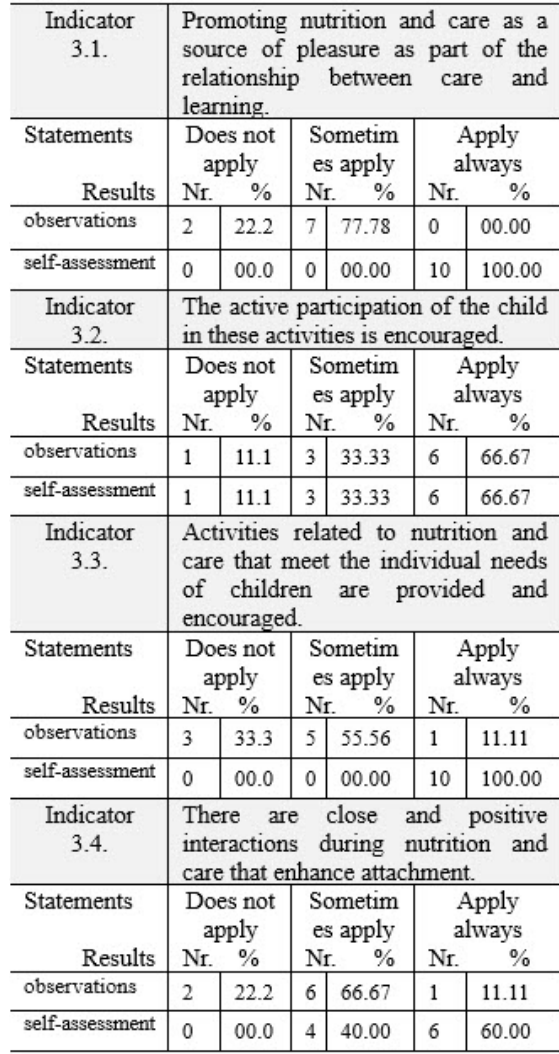
Table 16. Principle 3: Health care and nutrition are a source of pleasure and effec - tion.